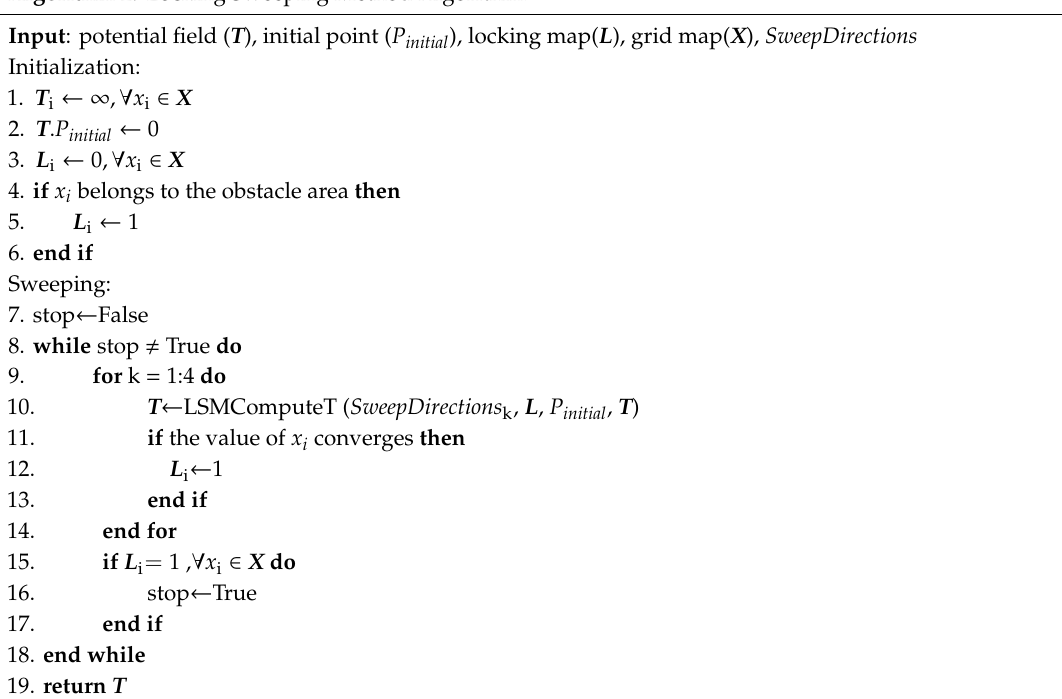
Algorithm 2. Locking Sweeping Method